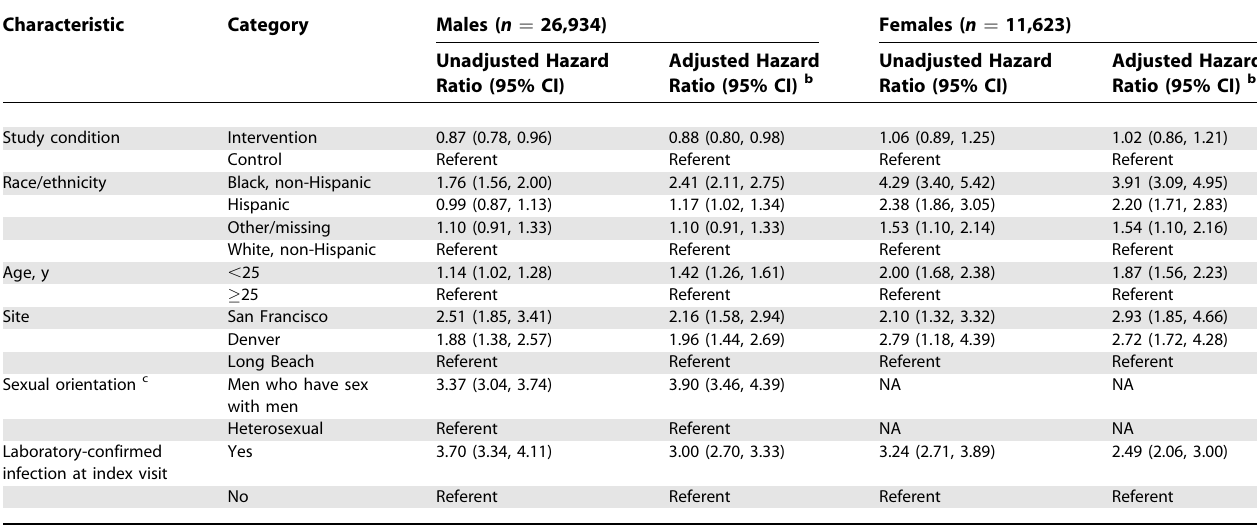
Table 3. Factors Associated with Diagnosis of Incident Laboratory-confirmed Infection among Patients at STD Clinics in Three U.S. Cities, December 2003–August 2005, by Sex